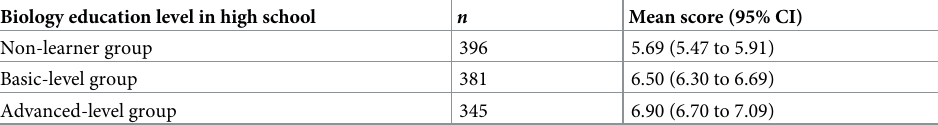
Table 3. Level of high school biology education and biology knowledge test score.